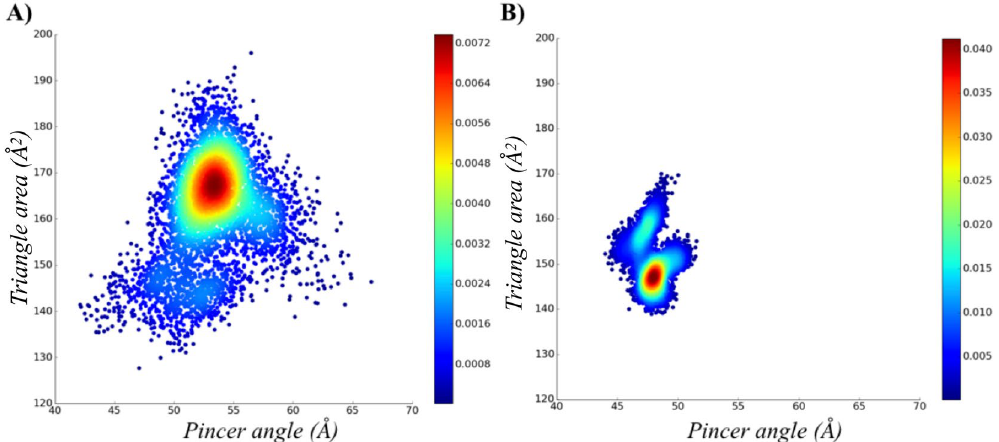
Figure 2. Description of the apo conformational ensembles of MtInhA. The probability density plots of ( A ) monomeric and ( B ) tetrameric forms highlight the difference between the conformational ensembles. Image generated with MatPlotlib 37 .